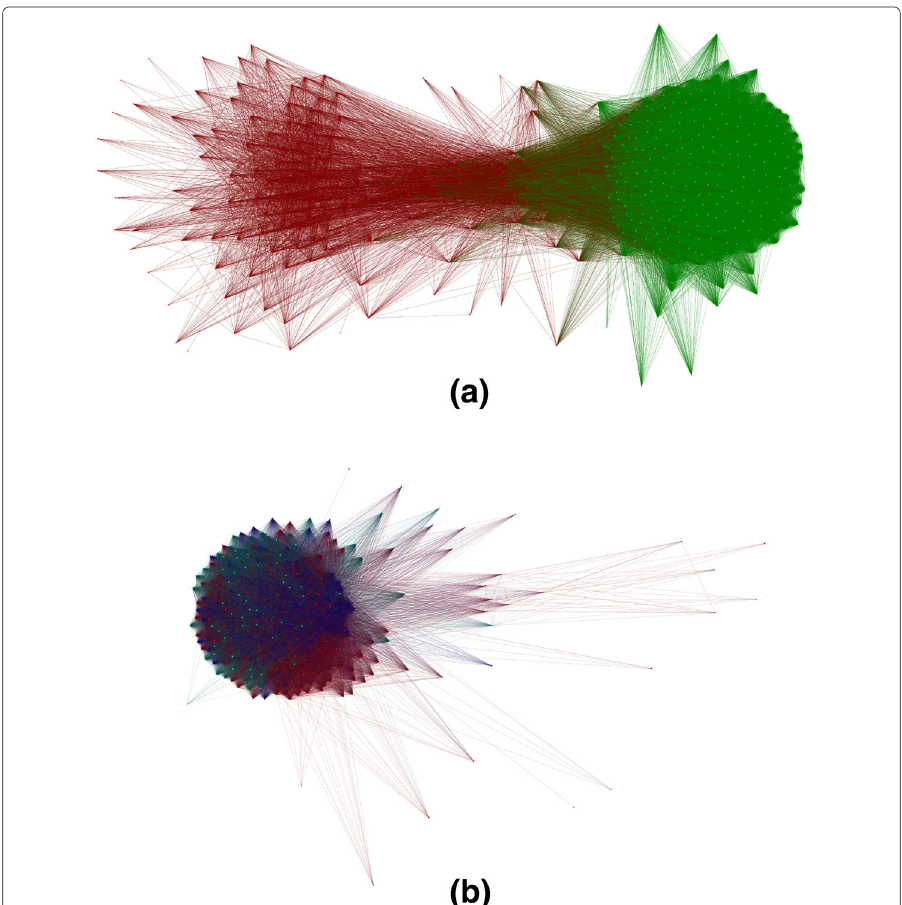
Fig. 2 Network visualization of the Rada in the first time segment in ( a ) and the second in ( b ). Links below the mean link value are not shown, nodes are colored by Louvain grouping for the individual time segment. The initial time segment shows clear group structure in the first time segment, with a minority group detached from a central core. The second time segment does not have clear groups, because the groups found are all